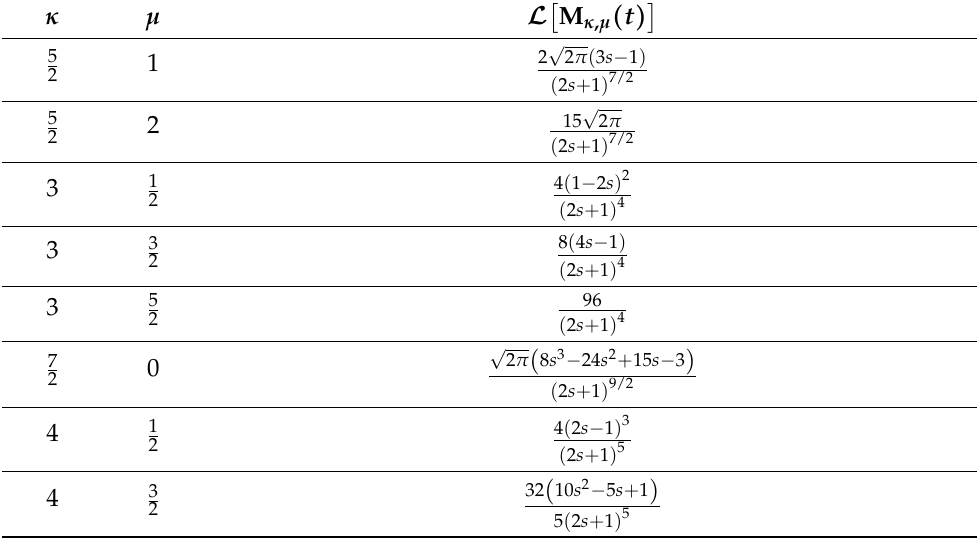
Table A9. The Laplace transforms of the Whittaker functions M κ , µ derived for some values of parameters κ and µ